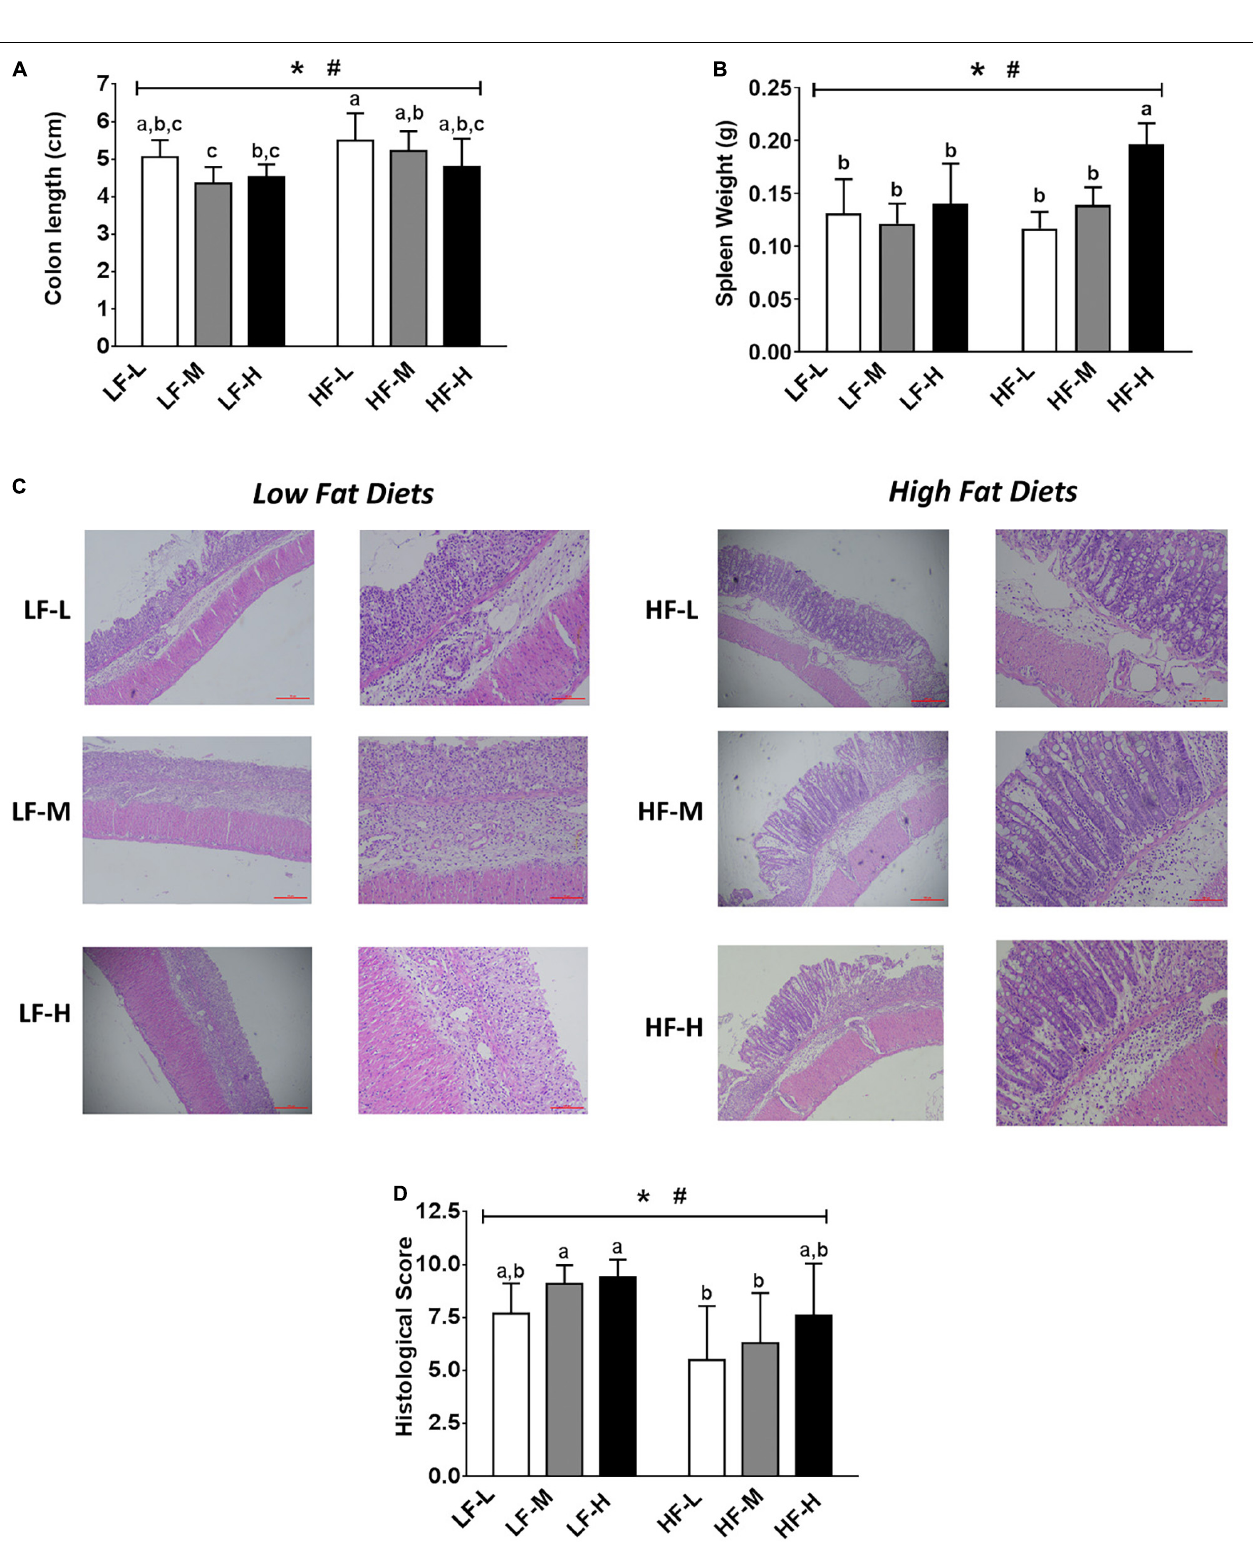
Frontiers in Nutrition |